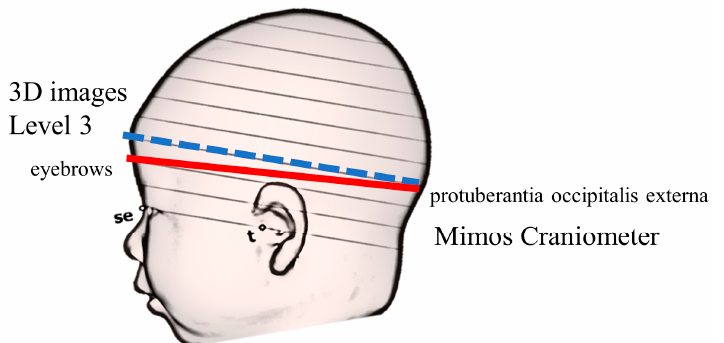
Figure 3. Difference between 3D images and caliper-measuring surfaces. This figure is a modified version of the figure prepared in our previous report [11]. The red line indicates the caliper-measuring surface, which is the circumference through the eyebrows and the protuberant occipitalis externa. The blue dotted line indicates the 3D image surface, which is the plane of level 3, horizontal to the reference plane. se, sellion; t, tragion.